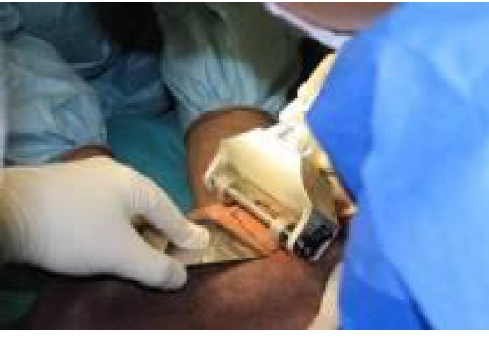
Figure 16. Cross-section of skin showing level of cut of skin for split